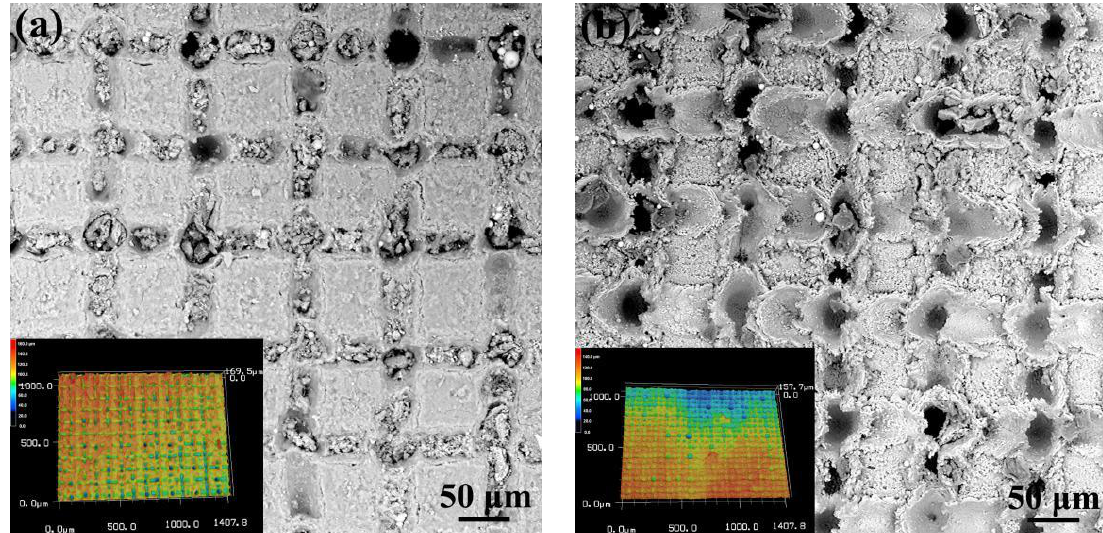
Figure 11. Surface morphology of the Al alloy joining interface pretreated by anodizing of 10 min and subsequent laser micro-texturing ( a ) and laser micro-texturing and subsequent anodizing of 10 min ( b ) (inset image showing the 3D morphology analyzed by LSCM with magnification of 400 × ).